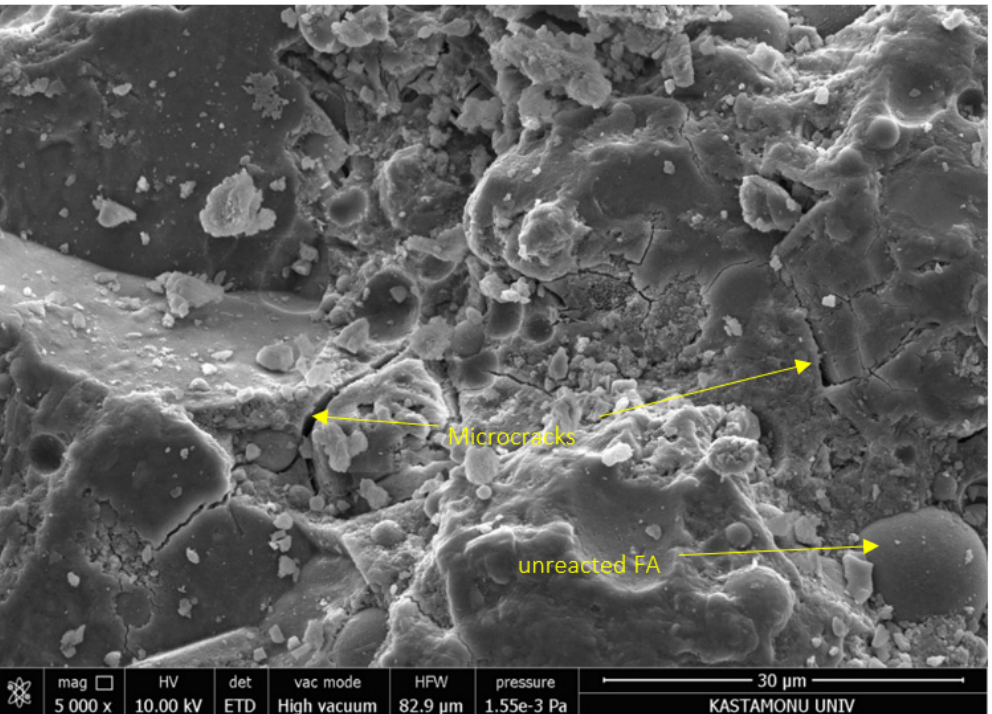
Figure 15. SEM of the 0 NCa sample magnified at 5000 times.